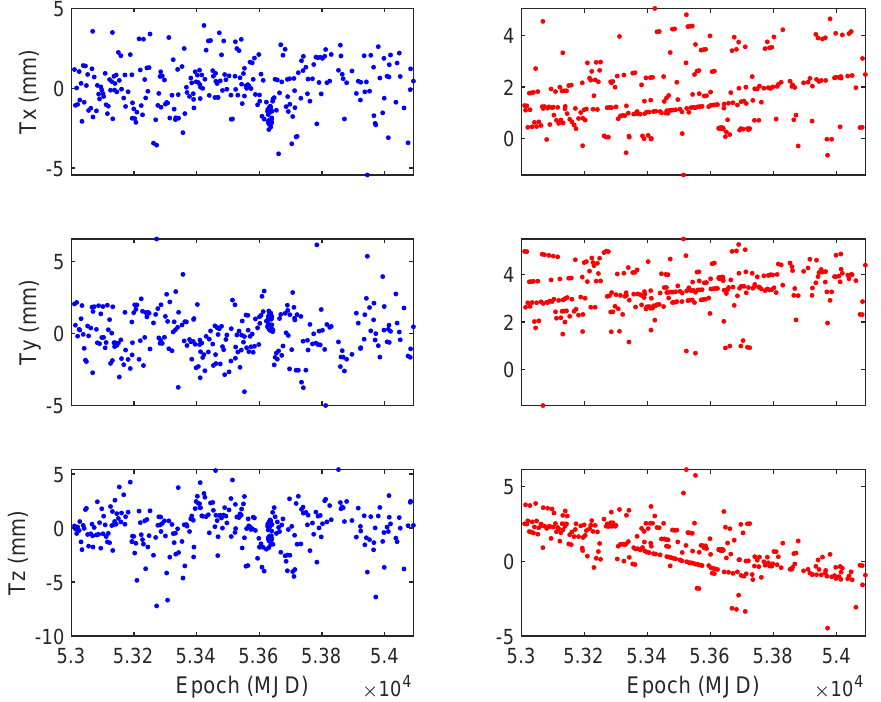
Figure 4. Time series of translation parameters with respect to the long-term solutions of tests 1 (blue) and 2 (red). MJD is Modified Julian